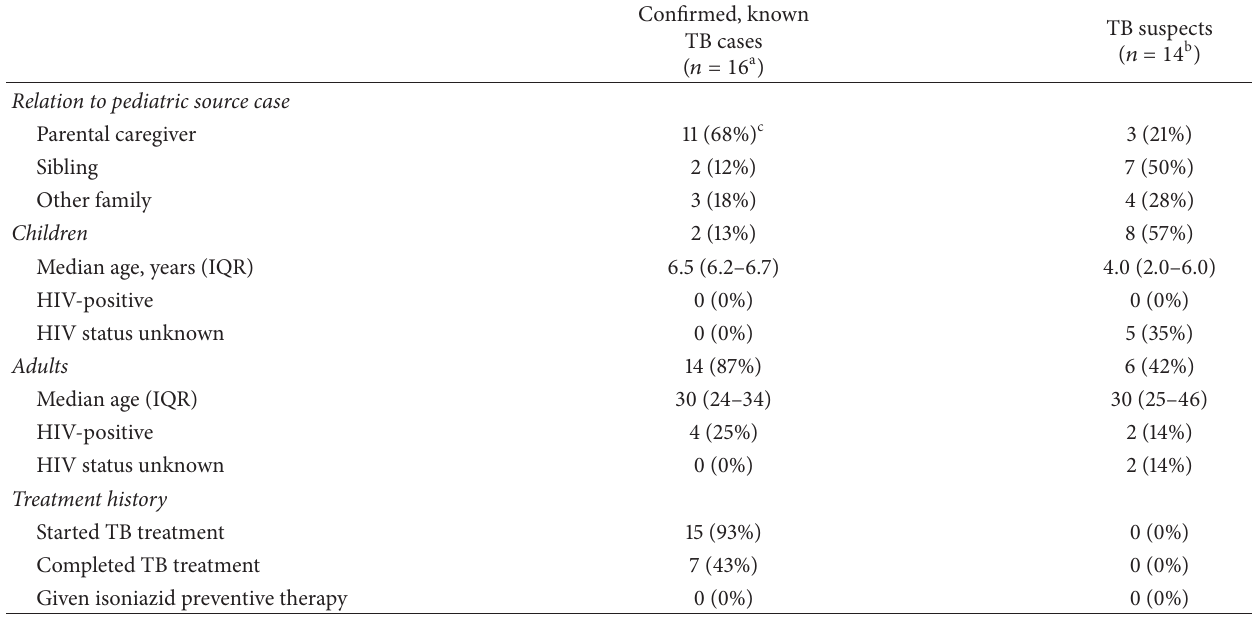
Table 3: Characteristics of prevalent TB cases and new TB suspects in the